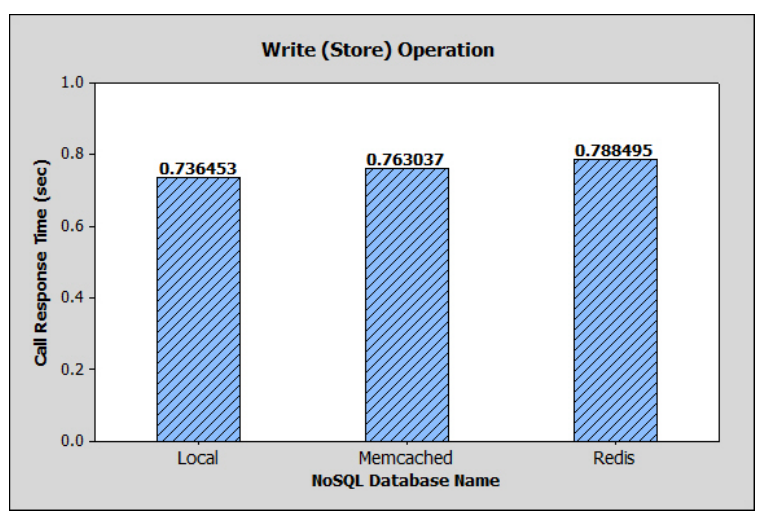
Figure 7. Call Response Time with write operation (Single